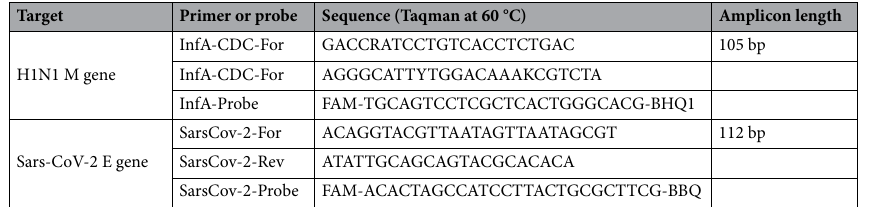
Table 2. Primers and probes used for RT-qPCR analysis of A(H1N1)pdm09 virus and